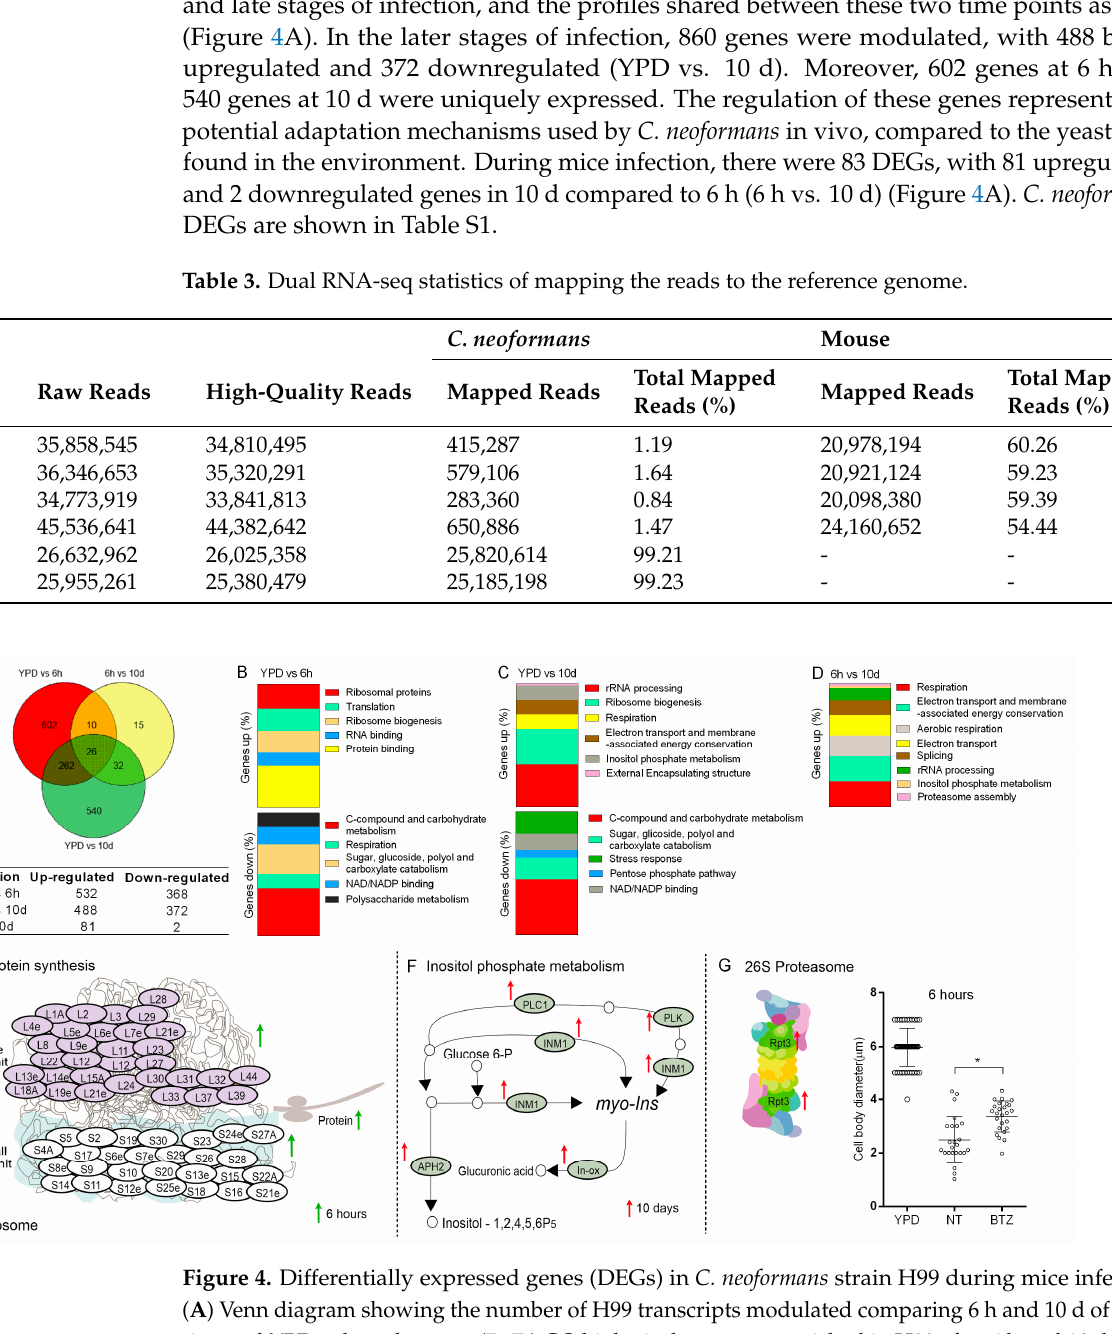
( G ) Differentially expressed genes related to fungal proteasome 10 d post infection, and the influence and the influence of bortezomib (BTZ) (proteasome inhibitor) on cell body diameter. Mean values of bortezomib (BTZ) (proteasome inhibitor) on cell body diameter. Mean values were compared with were compared with NT (* p < 0.05). Upward arrows indicate induction of gene expression. Upreg- NT (* p < 0.05). Upward arrows indicate induction of gene expression. Upregulated genes after 6 h ulated genes after 6 h are indicated by green arrows and upregulated genes after 10 days are indi- are indicated by green arrows and upregulated genes after 10 days are indicated by red cated by red arrows. Table 3. Dual RNA-seq statistics of mapping the reads to the reference genome.